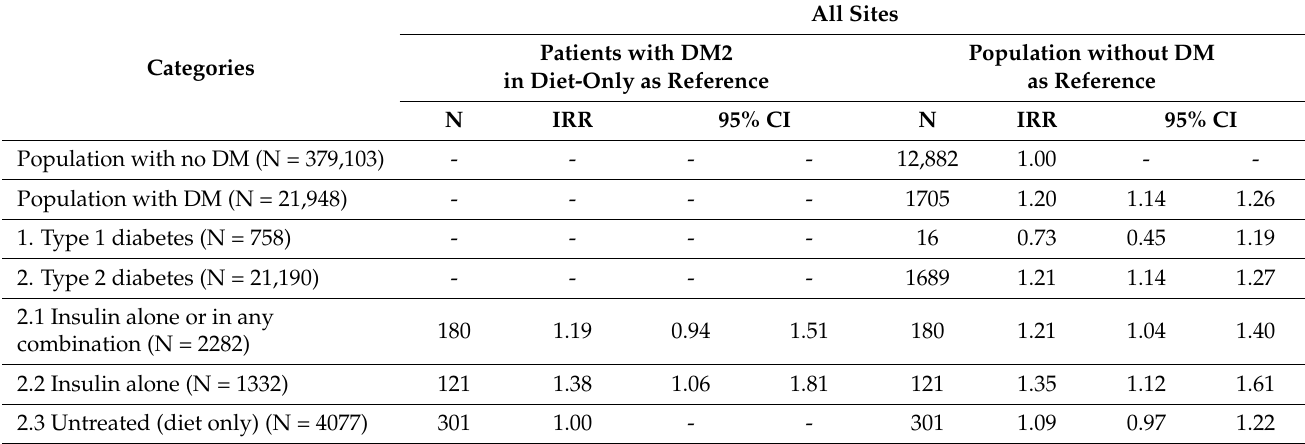
Table 2. Number, incidence rates ratios (IRR), and 95% confidence intervals (95% CI) of cancer